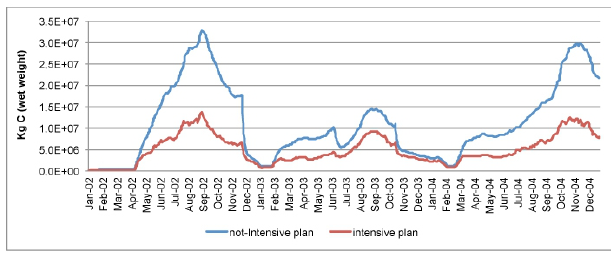
Fig. 10 . Total mussel carbon content simulated for intensive (socks 0.25 m apart, lines 2 m apart) and less intensive (socks 0.5m, lines 4 m apart) mussel farms in sub-basins Seno I and Seno II in